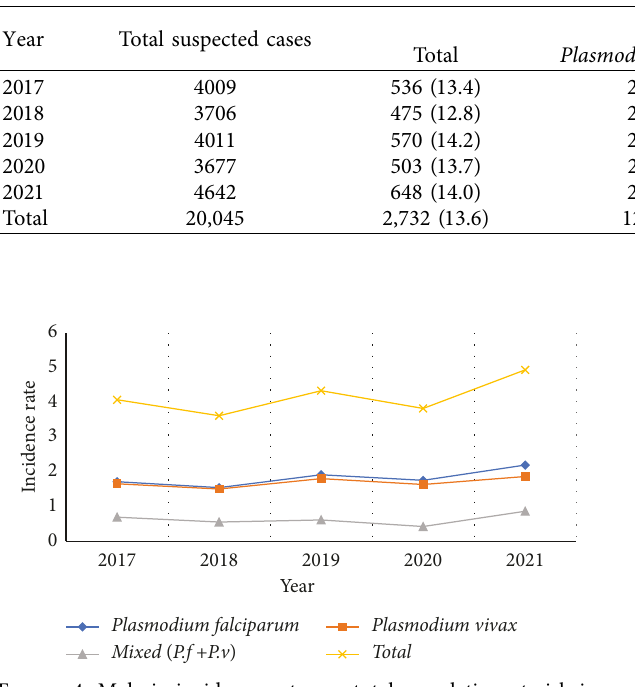
Figure 4: Malaria incidence rate per total population at risk in Decha and Gimbo districts, Southwest Ethiopia (2017-2021).